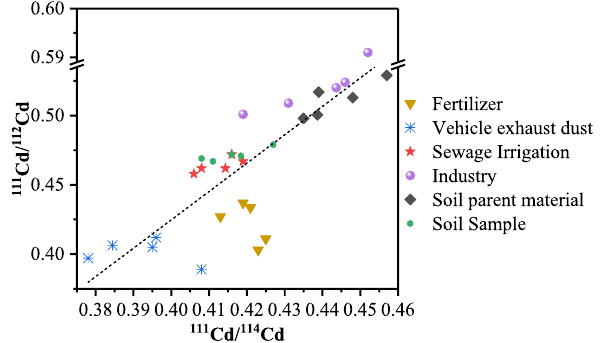
Figure 5. Cd isotope ratios of soil and potential source samples in the research area.